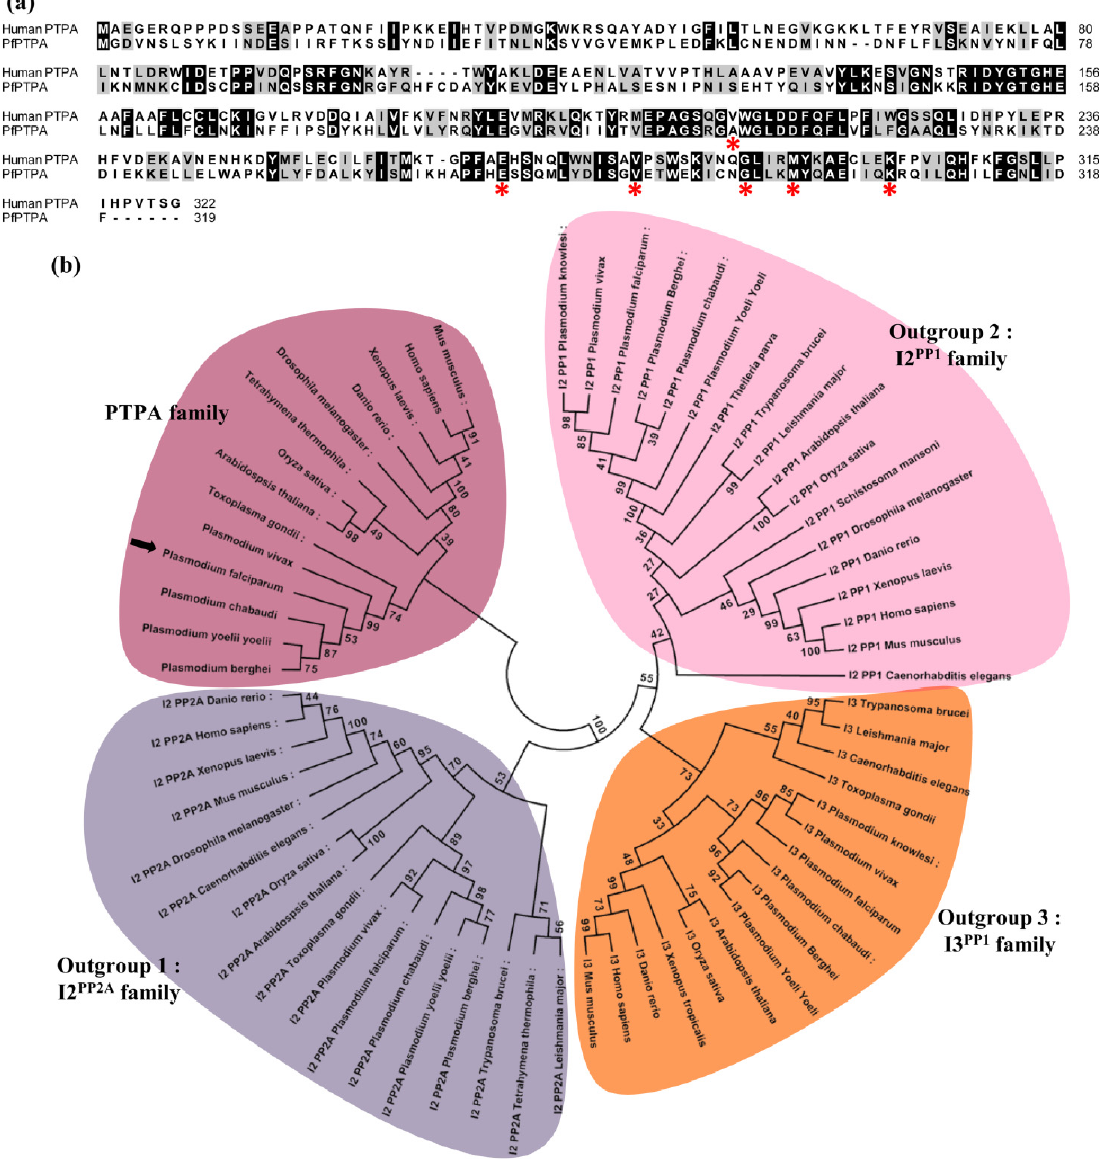
Figure 1. Molecular cloning and sequence analysis of PfPTPA. ( a ) Analysis of PfPTPA (PF3D7_1430100) amino acid sequence. PfPTPA was aligned with the human PTPA (CAA60163.1) using ClustalW Multiple Alignment (BioEdit). The identical residues are highlighted in black and similar residues in grey. Stars symbolized amino acids involved in PTPA/PP2A interaction in human; ( b ) Phylogenic tree of the PTPA family. A maximum likelihood tree was generated from the 21 PTPA sequences using MEGA5 [45] under the JTT + G + I model with 100 bootstrap repetitions. Outgroups are formed by PP2A inhibitor 2 orthologs (I2 PP2A , outgroup 1) PP1 inhibitor 2 orthologs (I2 PP1 , outgroup 2) and PP1 inhibitor 3 orthologs (I3 PP1 , outgroup 3); ( c ) Crystal structure of HuPTPA (PDB: 2IXM). Amino acid residues involved in PTPA/PP2A interaction are shown in red; ( d ) Structural model of PfPTPA based on the crystal structure of HuPTPA (PDB: 2IXM) using the ModBase server [46]. Amino acid residues studied in this work for the PTPA/PP2A interaction are shown in